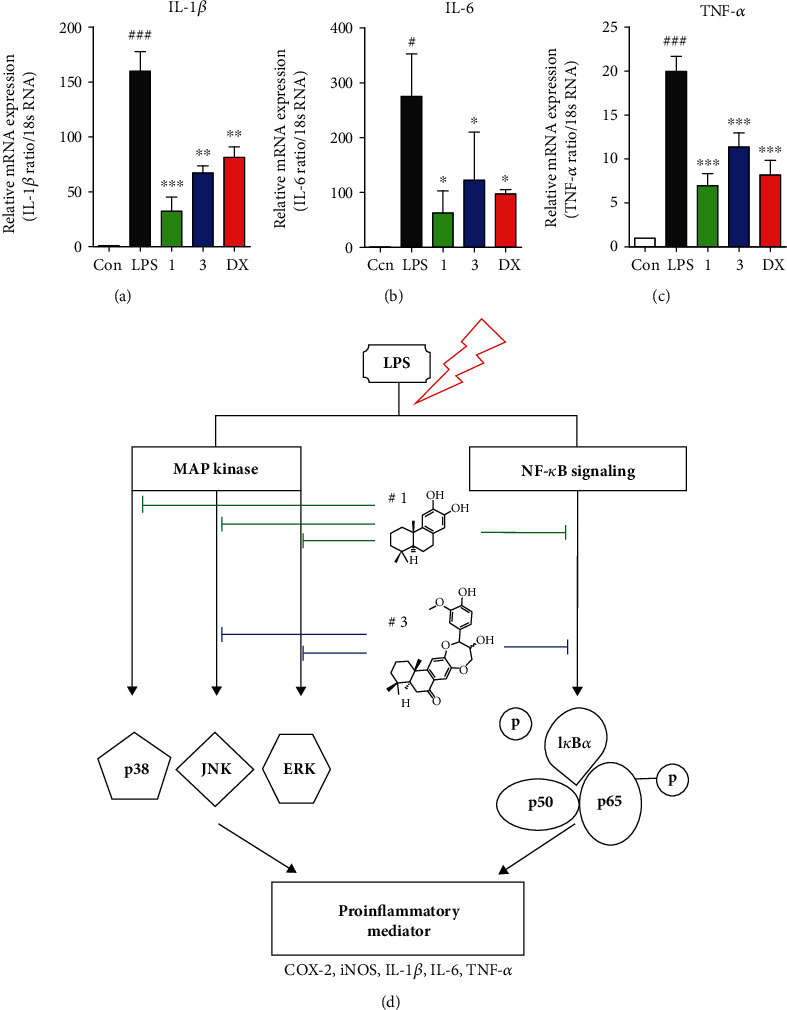
Compounds 1 and 3 downregulated proinflammatory mediators. (a–c) The mRNA expression levels of IL-1β, IL-6, and TNF-α were measured using quantitative real-time PCR experiment, and these proinflammatory cytokines were significantly diminished by compounds 1 and 3. Cells were preincubated for 2 h with compounds 1 and 3 at concentration of 5 and 10 μM, respectively, and activated by LPS (1 μg/mL) for 2 h. Results represent as mean ± SEM, and dexamethasone was used as a positive control. #p < 0.05, ###p < 0.001, ∗p < 0.05, ∗∗p < 0.01, and ∗∗∗p < 0.001 indicated significant differences from the LPS-treated group. (d) Graphical depiction of the potent anti-inflammatory activity of compounds 1 and 3 in LPS-activated RAW264.7 cells by suppressing the MAPK and NF-κB signaling pathway.